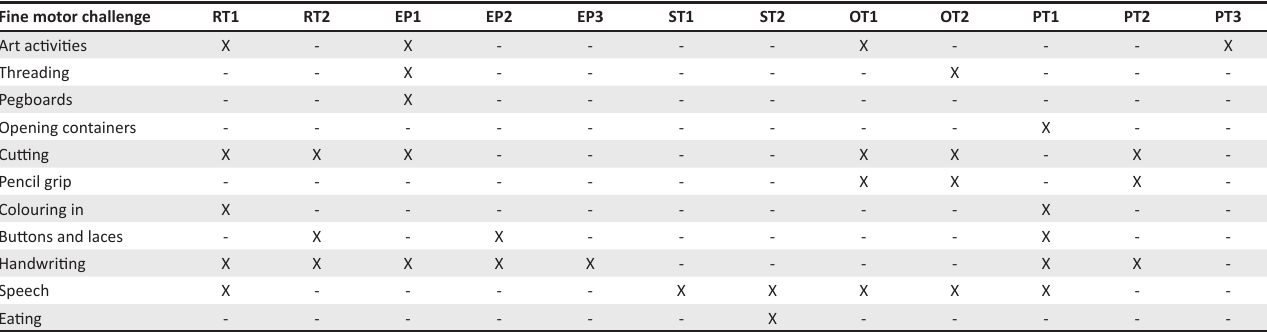
TABLE 2: Fine motor challenges. Fine motor